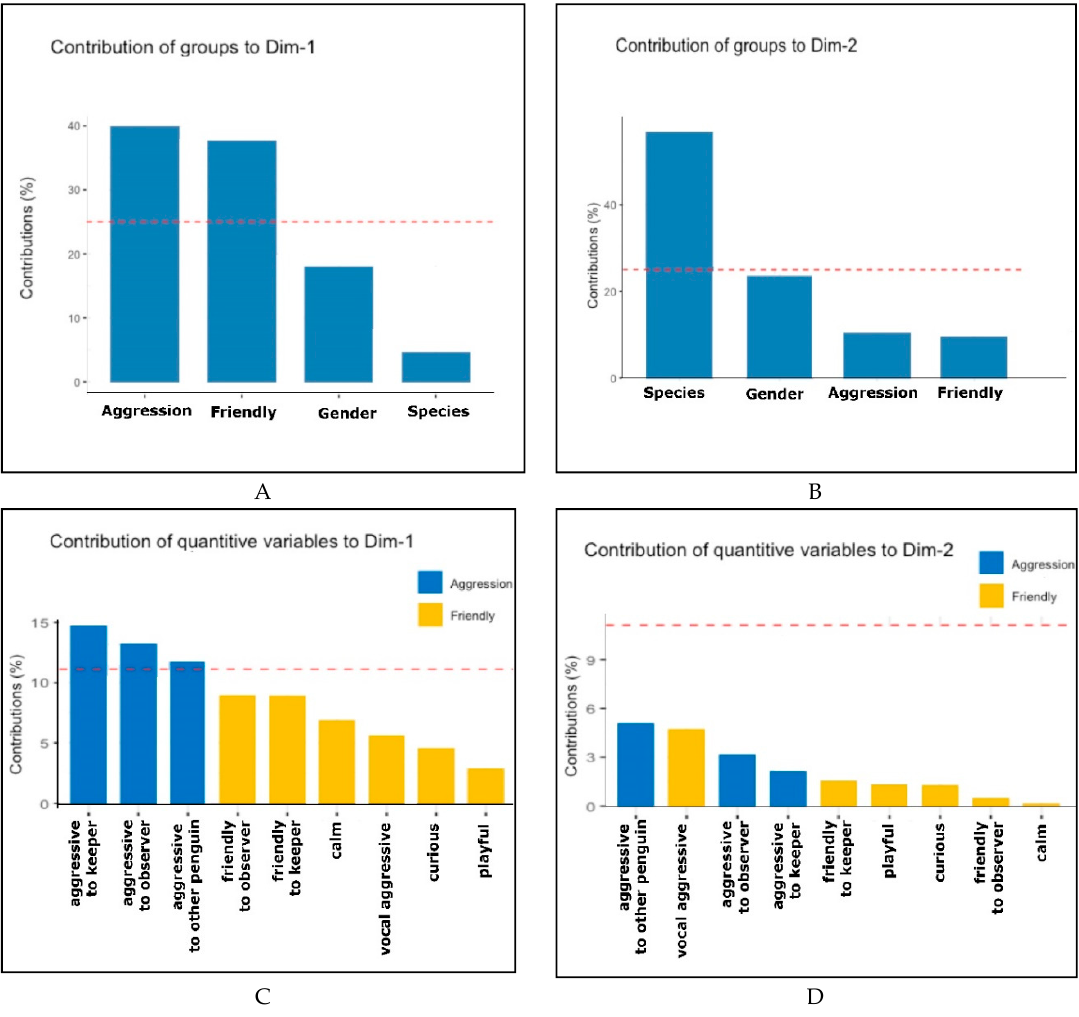
Figure 4. Graphic representation of the contribution (expressed as a percentage) of the groups and of the considered variables in the analysis in Dimensions 1 and 2. In ( A ) Contribution of the groups to Dimension 1; in ( B ) Contribution of quantitative variables to Dimension 1; in ( C ) Contribution of the groups to Dimension 2; in ( D ) Contribution of quantitative variables to Dimension 2. The red line represents the threshold where variables are judged to be contributing ‘significantly’. It is a guideline base on the relative proportions of variance and not a formal significance test.